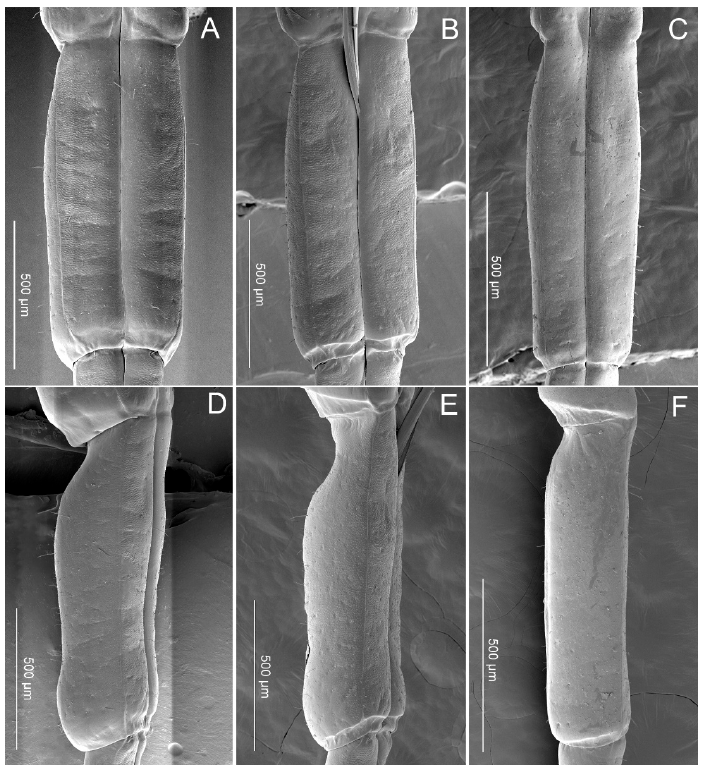
Figure 7. SEM images of the third labial segment. ( A ) Ventral view of Picromerus bidens ; ( B ) Ventral view of Picromerus lewisi ; ( C ) Ventral view of Cazira bhoutanica ; ( D ) Lateral view of Picromerus bidens ; ( E ) Lateral view of Picromerus lewisi ; ( F ) Lateral view of Cazira bhoutanica.